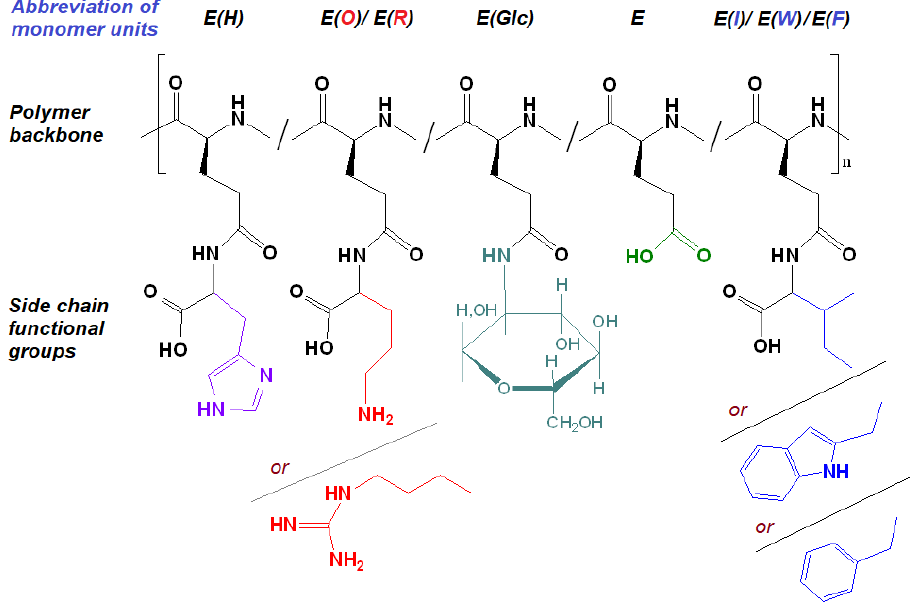
Figure 3. Amphiphilic copolymers obtained after the removal of side protective groups. Table 1. Composition of the amphiphilic copolymers, as determined by quantitative HPLC amino acid